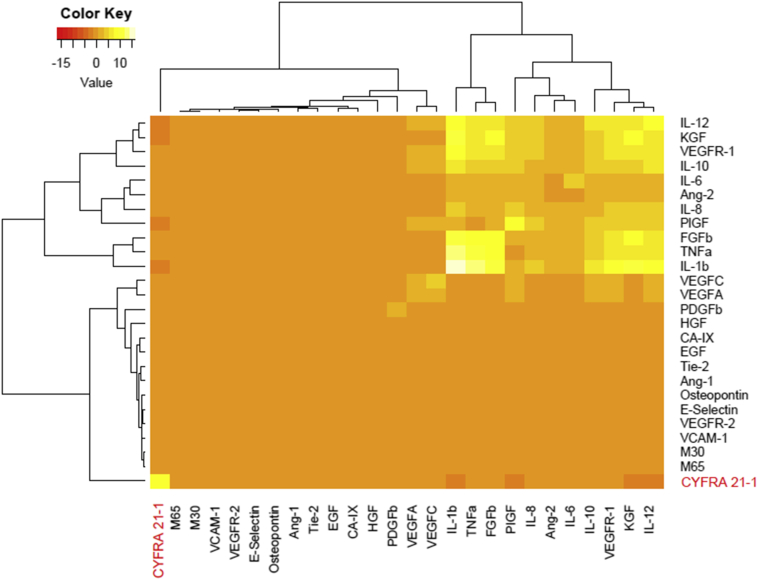
Heat Map (With Clustergram) of the Variance–Covariance Matrix After Data Were Log-Transformed and Each Marker Scaled by Its Mean Value for Day 21Abbreviations: Ang = angioprotein; CA-IX = carbonic anhydrase; CYFRA 21-1 = cytokeratin-19 antigen; EGF = epidermal growth factor; FGFb = basic fibroblast growth factor; HGF = hepatocyte growth factor; IL = interleukin; KGF = keratinocyte growth factor; M30 = cytokeratin 18 cleaved; M65 = cytokeratin 18 intact; PDGFb = platelet-derived growth factor B; PIGF = placenta growth factor; Tie-2 = tyrosine kinase 2; TNF = tumor necrosis factor; VCAM = vascular cell adhesion molecule; VEGF = vascular endothelial growth factor; VEGFR = vascular endothelial growth factor receptor.